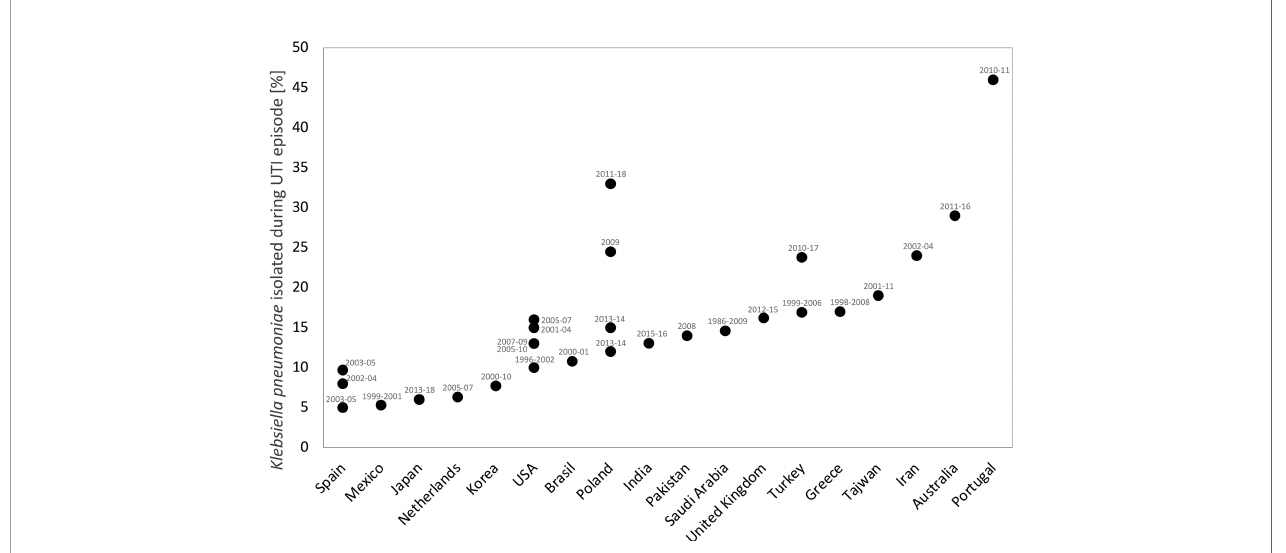
FIGURE 1 | The incidence of K. pneumoniae UTIs in renal transplant recipients by countries in which the study was conducted. The study period (in years) is shown in the labels. This analysis was performed based on following references: Abbott et al., 2004; Charfeddine et al., 2002; Chuang et al., 2005; Alangaden et al., 2006; Dantas et al., 2006; Valera et al., 2006; Dupont et al., 2007; Memikog ̆ lu et al., 2007; Pourmand et al., 2007; Lo ́ pez-Medrano et al., 2008; Giullian et al., 2010; Iqbal et al., 2010; Rivera-Sanchez et al., 2010; Fiorante et al., 2011; Go ł ę biewska et al., 2011; Papasotiriou et al., 2011; Barbouch et al., 2012; Vidal et al., 2012;